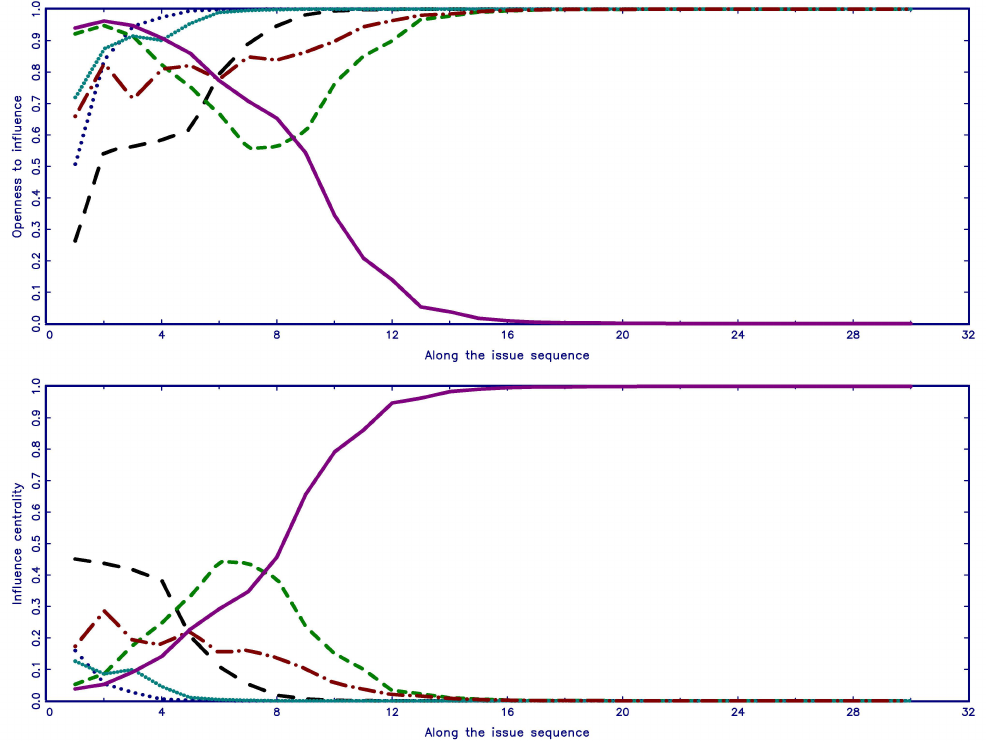
Figure 2: Illustration of the predicted evolution in a n = 6 group with the same initial conditions of the Figure 1 group. The group’s strongly connected configuration of relative interpersonal interpersonal influences is stable as in Figure 1, but here the values of allocated influences are randomly disturbed along the issue sequence on each issue s = 2, 3, . . .